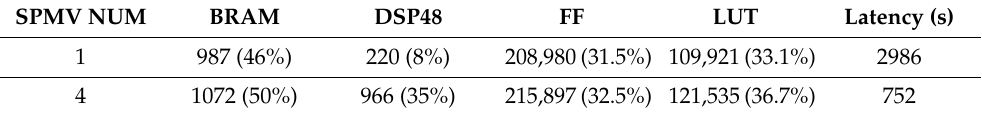
Table 1. Comparison between two schema (generating one SPMV PE or four SPMV PEs). SPMV